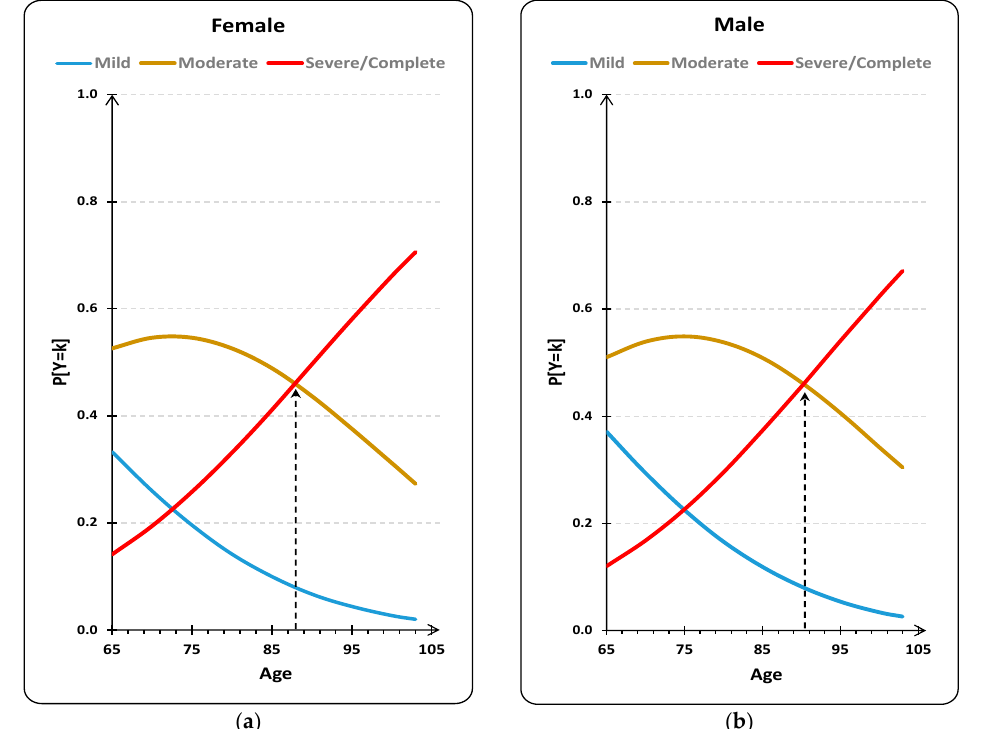
Figure 4. Evaluation of the probabilities for mild, moderate and severe dependence for women ( a ) and men ( b ) ( (cid:2031) (cid:2870) (cid:4666)2(cid:4667) = 274.822;(cid:1868) < 0.001; (cid:1844) (cid:3014)(cid:3007)(cid:2870) = 0.096; (cid:1844) (cid:3015)(cid:2870) = 0.132;(cid:1844) (cid:3004)(cid:3020)(cid:2870) = 0.129 ).